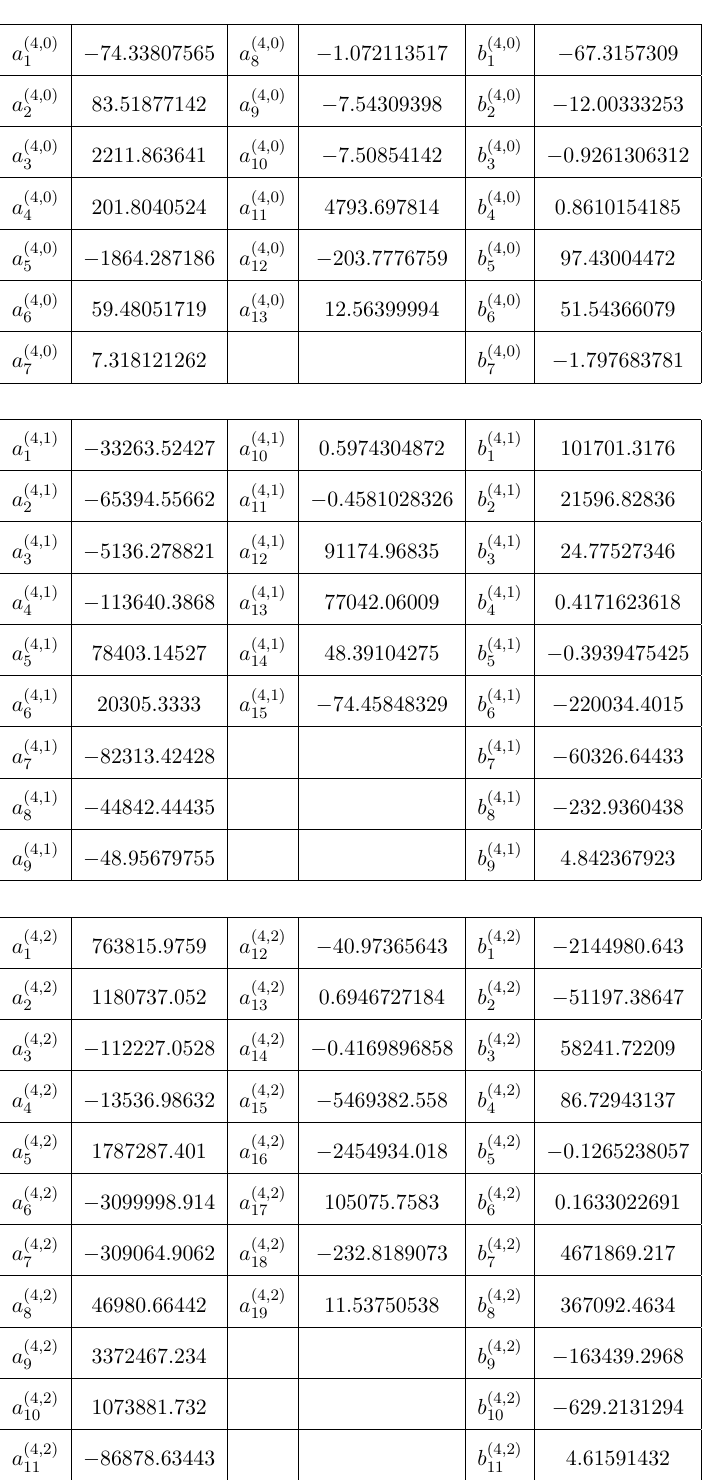
Table 4 . Coe(cid:14)cients of the (cid:12)t functions F (4 ;j ) for j = 0 ; 1 ; 2.